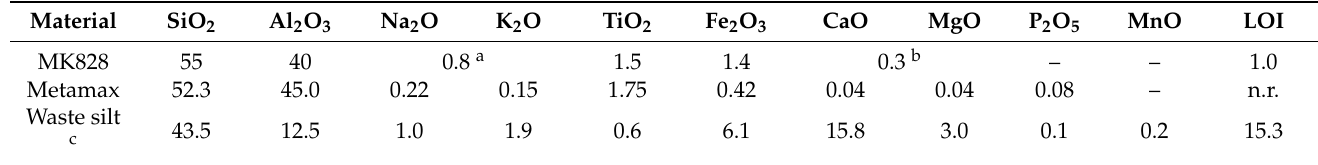
Table 1. Metakaolin and waste silt chemical composition (values reported as weighted percentages wt%).